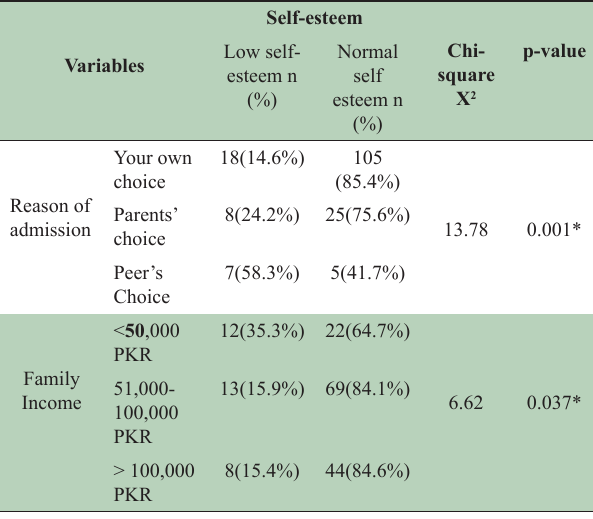
Table-III: Association between self-esteem and some other variables among the participants.